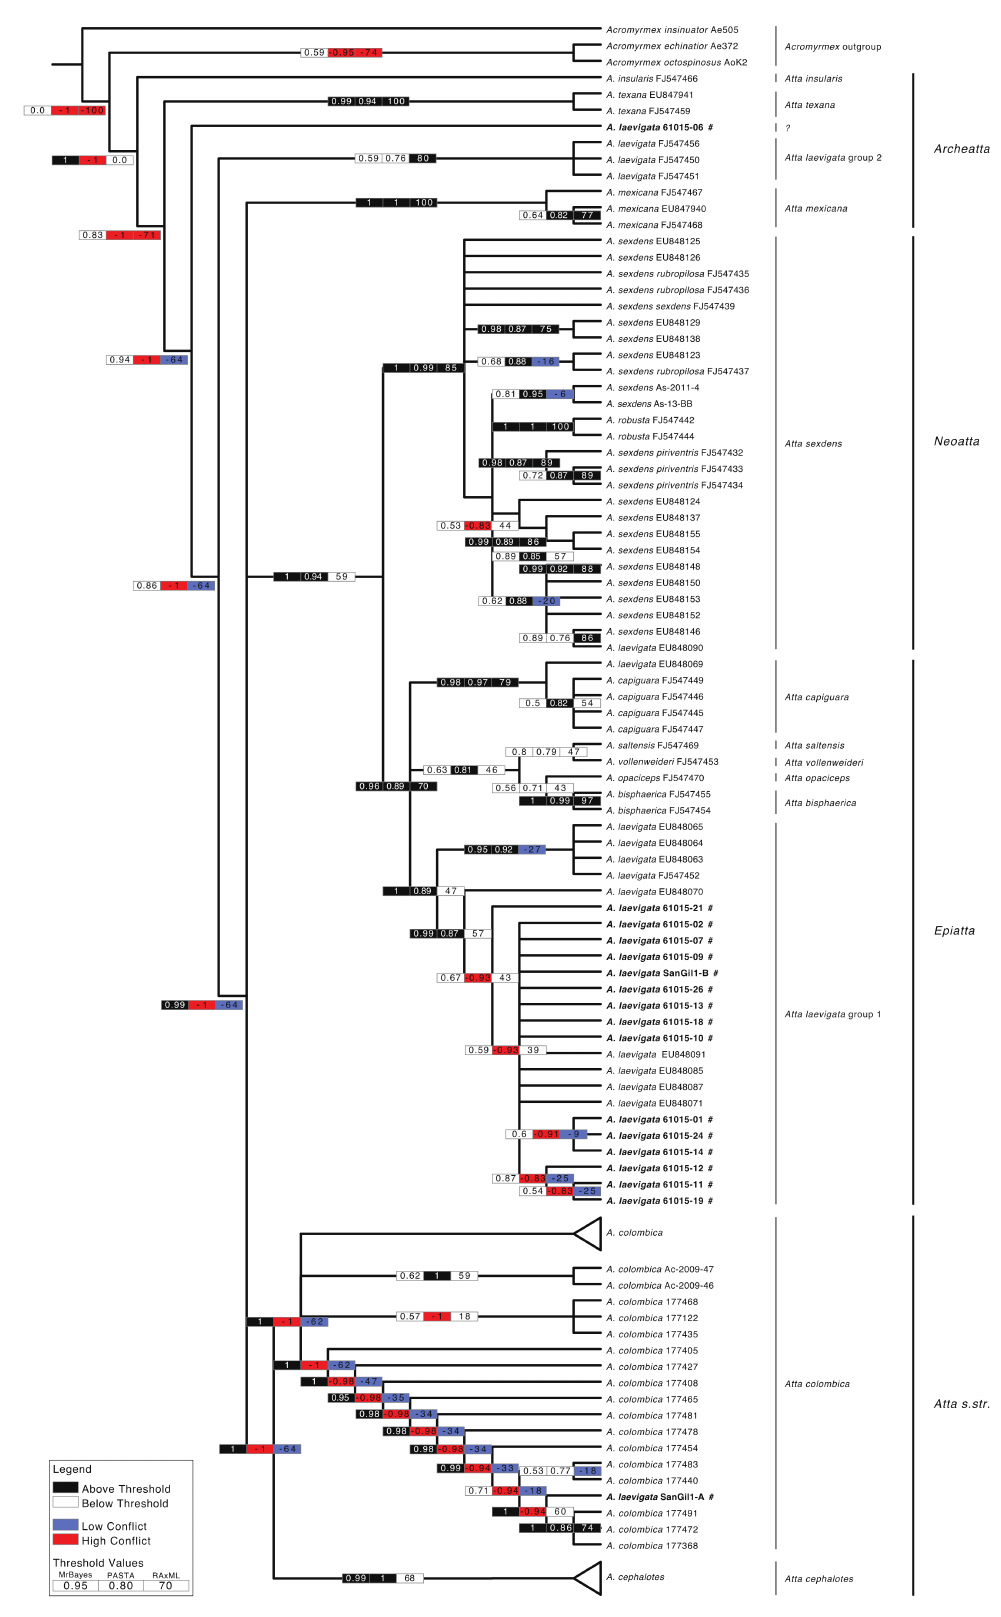
Figure 2. Phylogenetic relationships among 18 Atta members as reconstructed in the majority-rule consensus tree obtained with the Bayesian analyses. Three Acromyrmex species were used as the